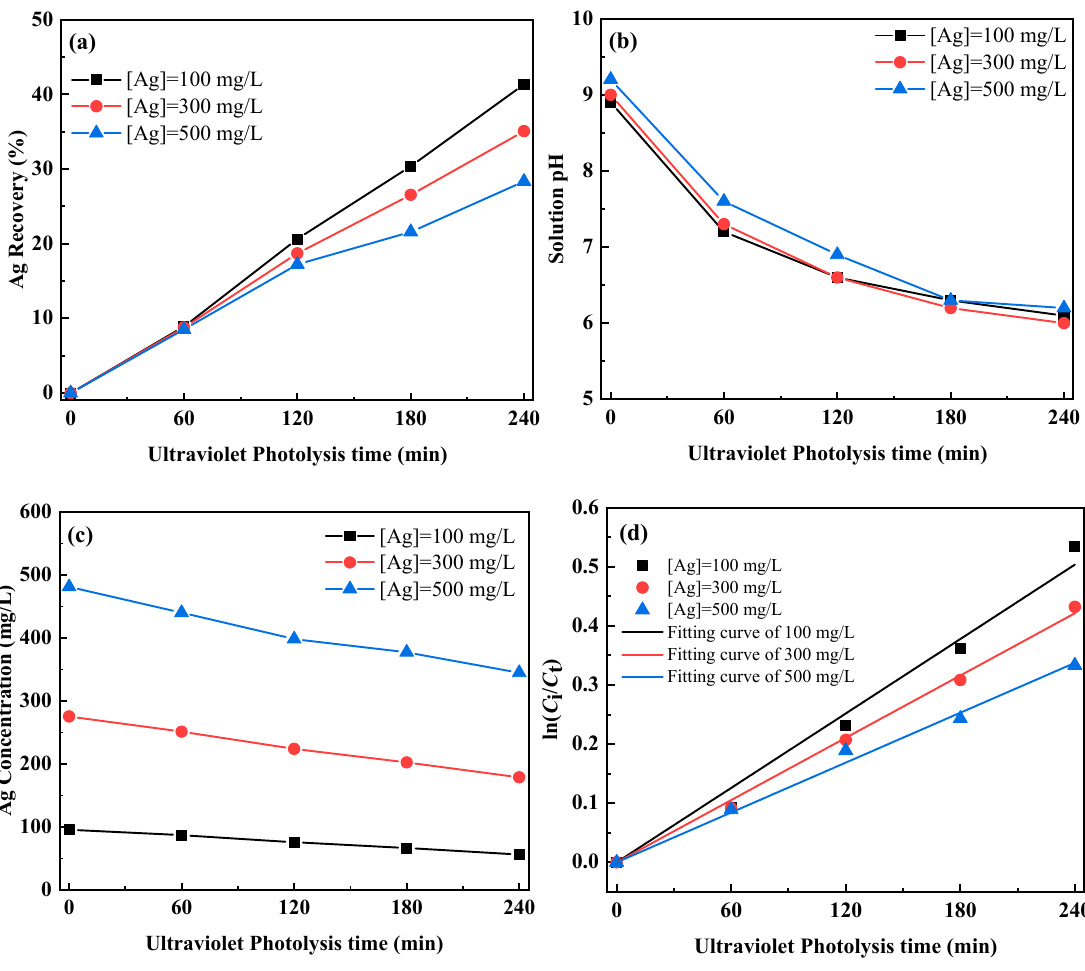
Figure 2. Effect of silver concentration on the photolysis of a silver–thiosulfate complex by UV-C ( a ) Ag recovery vs. time; ( b ) variation for solution pH; ( c ) Ag concentration vs. time; ( d ) plot of ln ( C i / C t ) vs. time; [S 2 O 32 − ] = 0.1 mol/L, 298 K, uncontrolled pH.